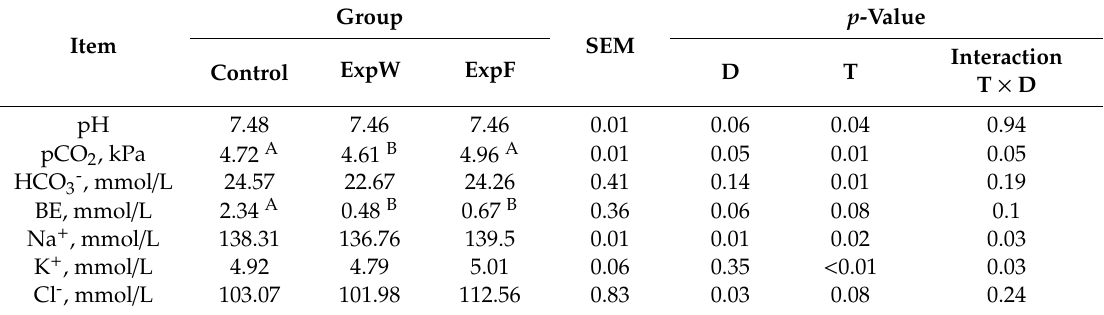
Table 4. Mean values of acid-base balance and electrolyte parameters in rabbit blood.